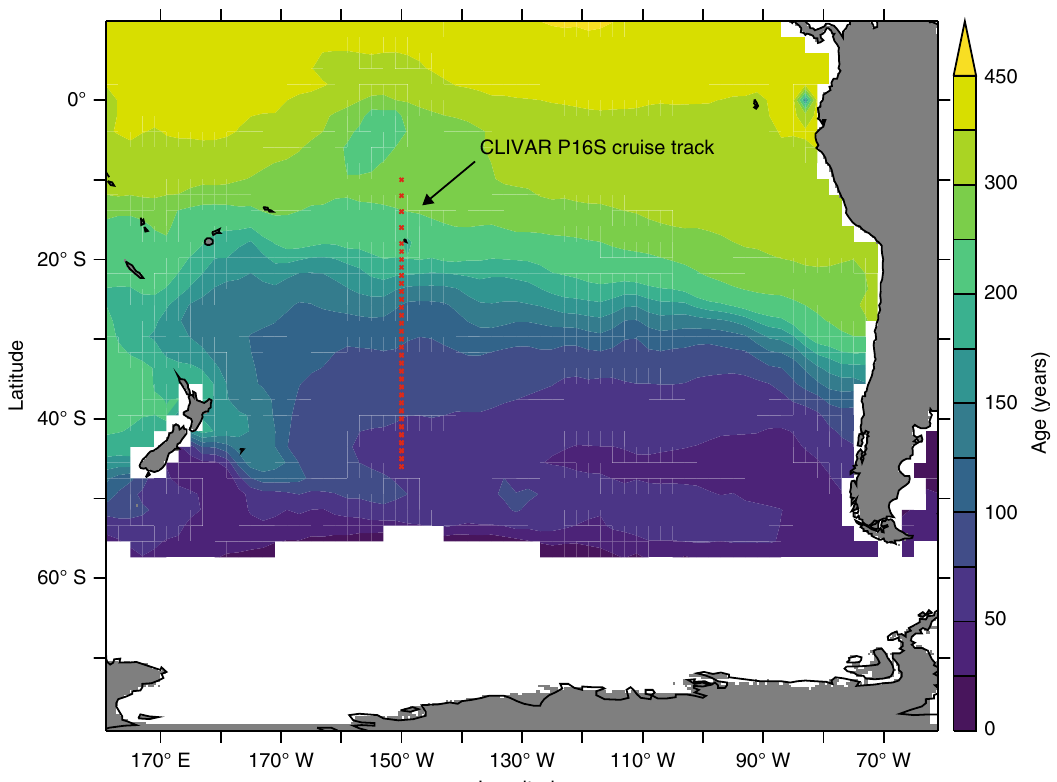
Fig. 1 Study area. The southern part of the CLIVAR P16S line in the south Paci fi c Ocean, on a backdrop of water age (years) from the OCIM model averaged over the intermediate water isopycnal layers ( σ 0 = 26.8 – 27.2). The individual stations used in this analysis are marked with red